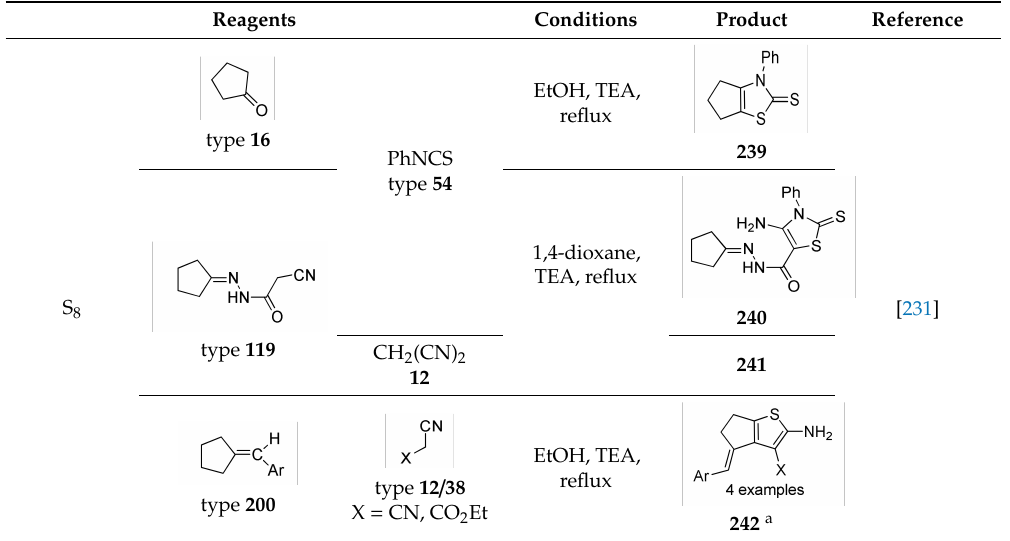
Table 6. Multicomponent synthesis of cyclopentanone-based thiophene / thiazol heterocyclic systems 239 – 242 of potential anticancer